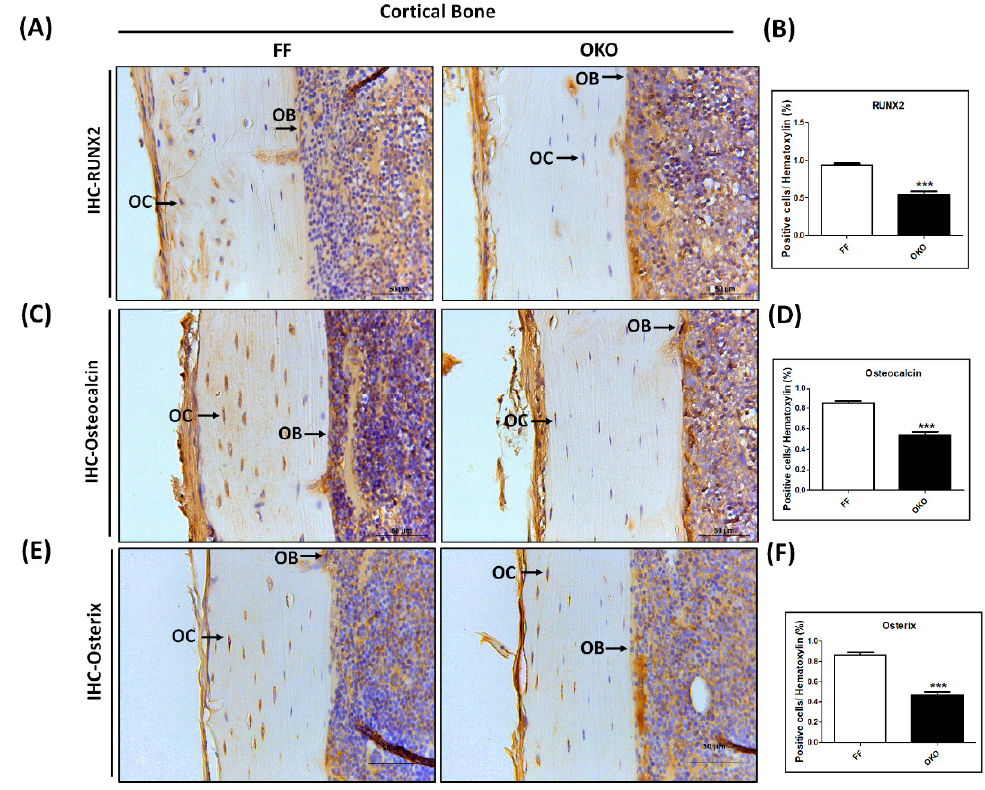
Figure 4. DDR1 deficiency significantly reduced osteogenesis-related protein expression. ( A ) The representative micrographs of immunolocalized osteogenesis-related protein RUNX2. ( B ) Quantitative results of RUNX2. ( C ) The representative micrographs of immunolocalized osteogenesis-related protein osteocalcin. ( D ) Quantitative results of osteocalcin. ( E ) The representative micrographs of immunolocalized osteogenesis-related protein osterix. ( F ) Quantitative results of osterix. All results were present in the cortical bone of the femur in 12-week-old FF and OKO mice. The positive immunolocalizations are stained dark brown. A black arrow indicates positive cells (OB + OC); OB: osteoblasts, OC: osteocytes. Magnifications of 400× are shown, with scale bars of 50 μ m. Each bar represents the mean ± SE of six samples in each group (*** p < 0.001 versus FF mice).